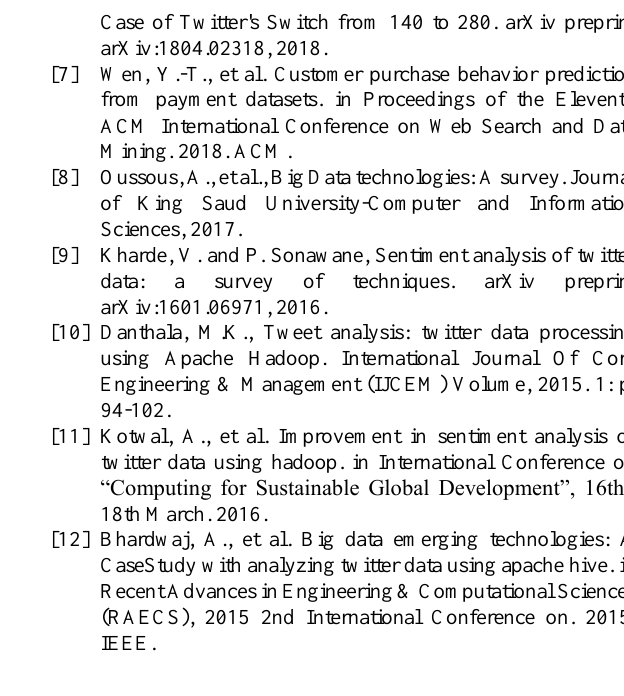
Figure 1-People opinion about 4 laptop brands in 8